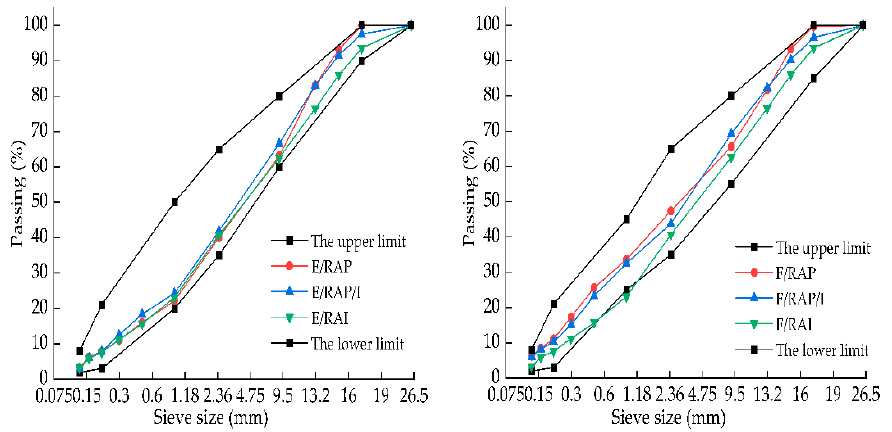
Figure 2. Design gradations of emulsified and foamed asphalt CRMs.